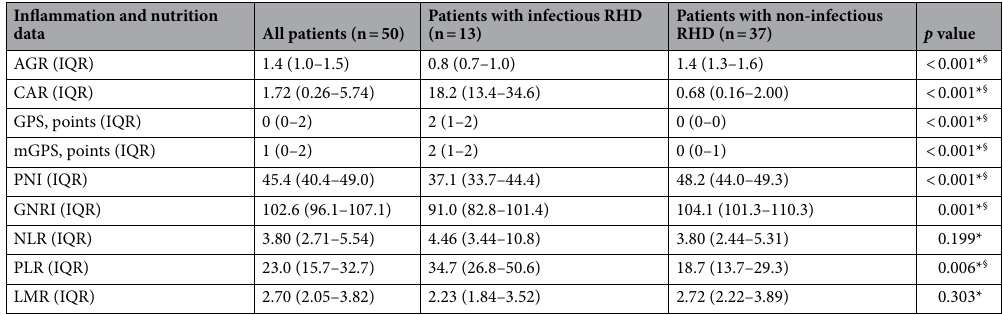
Table 3. Patient laboratory, inflammation and nutrition data. AGR Albumin/globulin ratio, CAR CRP- albumin ratio, GNRI Geriatric nutritional risk index, GPS Glasgow prognostic score, IQR Interquartile range, LMR Lymphocyte/monocyte ratio, mGPS Modified Glasgow prognostic score, NLR Neutrophil/lymphocyte ratio, PLR Platelet/lymphocyte ratio, PNI Prognostic nutrition index, RHD Rapid hip destruction. *Mann– Whitney’s U test. § Statistically significant.